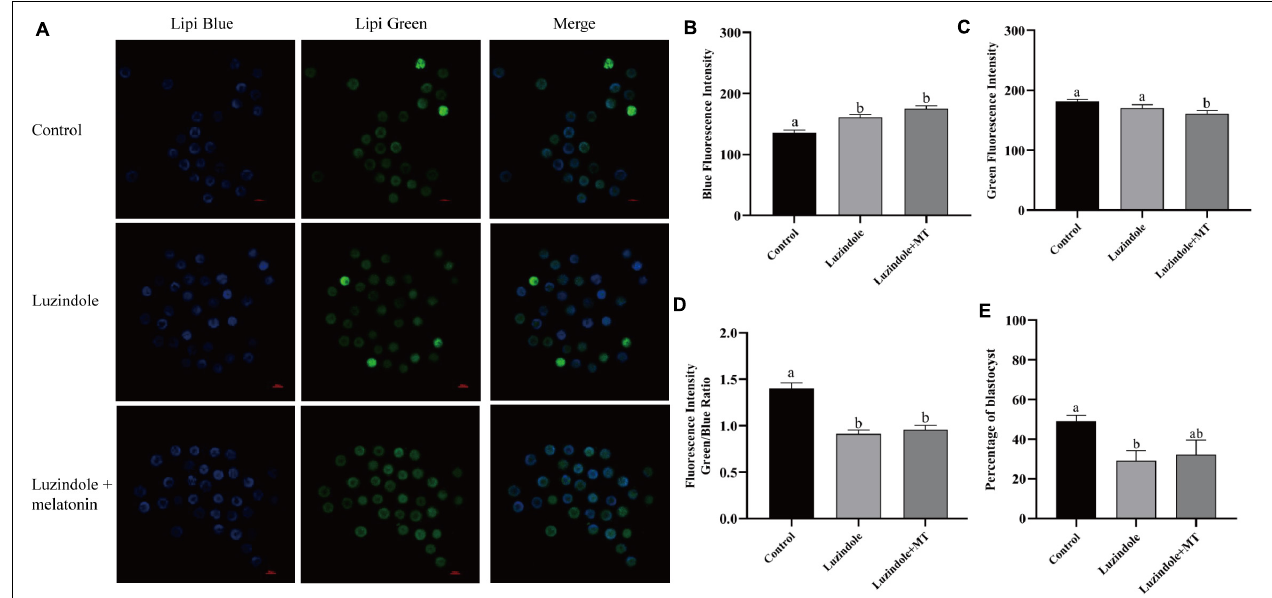
FIGURE 5 | Melatonin receptors participate in the regulation of lipid metabolism in porcine oocytes. (A) Representative images of Lipi-Blue fluorescence (blue) in porcine oocytes treated with control, luzindole, and luzindole + melatonin. Scale bar: 100 µ m. (B) Quantification of fluorescence intensity of Lipi-Blue in porcine oocytes treated with control ( n = 75), luzindole ( n = 107), and luzindole + melatonin ( n = 53). (C) Quantification of fluorescence intensity of Lipi-Green in porcine oocytes treated with control ( n = 70), luzindole ( n = 94), and luzindole + melatonin ( n = 57). (D) Ratio of fluorescence intensity of Lipi-Blue and Lipi-Green in porcine oocytes treated with control ( n = 70), luzindole ( n = 101), luzindole + melatonin ( n = 52). Student’s t -test and one-way ANOVA were utilized for statistical analyses. Different lowercase letters indicate significant differences. Error bars indicate SEM. (E) The percentage of blastocysts in porcine oocytes treated with control ( n = 400), Luzindole ( n = 204), Luzindole + melatonin ( n =